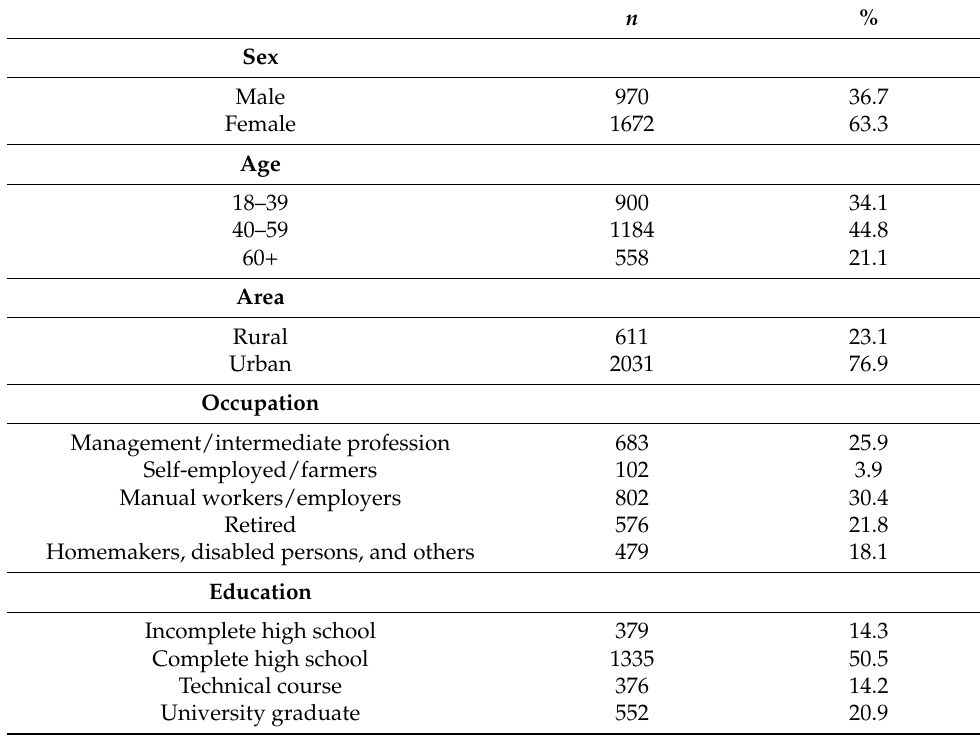
Table 1. Sociodemographic characteristics of the 2642 adults aged 18–74 years with complete data.